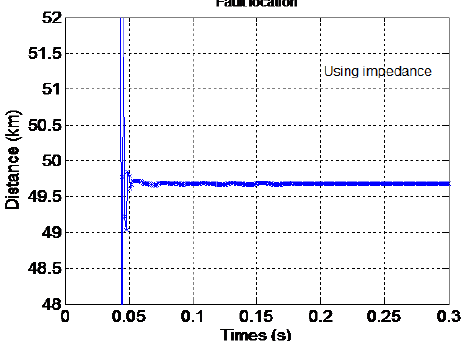
Fig. 10: Fault location as function of time using the